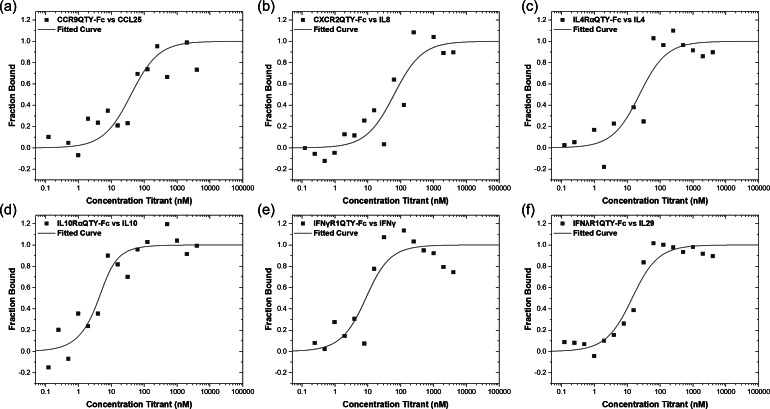
Microscale thermophoresis (MST) ligand-binding measurements. The receptors were labelled with fluorescent dye. The ligands were purchased commercially from and dissolved in deionized water. (a) CCR9QTY–Fc with CCL25; (b) CXCR2QTY–Fc with IL8; (c) IL4RαQTY–Fc with IL4; (d) IL10RαQTY–Fc with IL10; (e) IFNγR1QTY–Fc with IFNγ and (f) IFNλR1QTY–Fc with IL29. The K
d values calculated from the graphs are listed in Table 1.